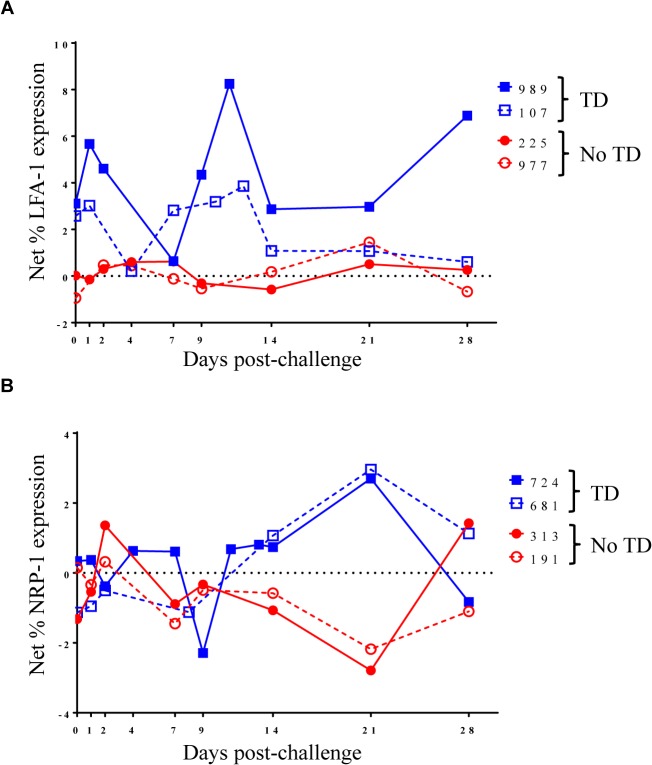
Kinetics of S. Typhi-specific modulation of LFA-1 and NRP-1 expression on circulating Treg following challenge.Kinetic curves from representative volunteers showing net S. Typhi-specific modulation of the expression of A) LFA-1 and B) NRP-1 from day 0 (pre-challenge) until day 28 post-challenge.